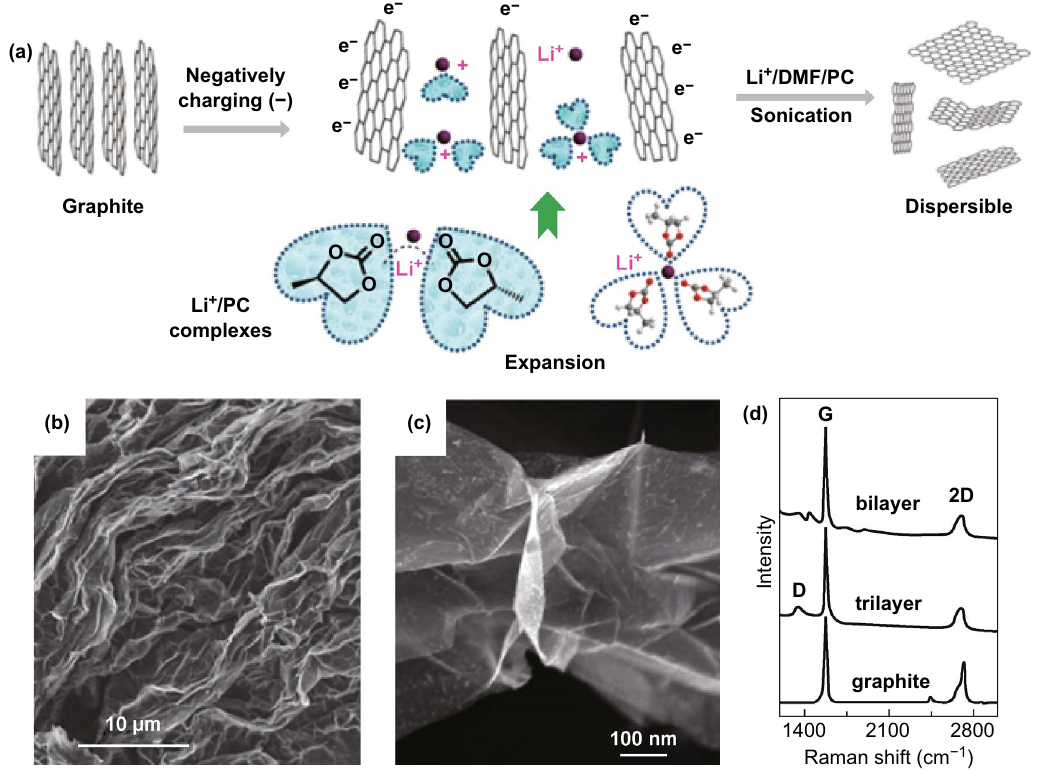
Fig. 8 a Schematic illustration of cathodic exfoliation of graphite by intercalation of Li + complexes. b , c SEM images of the cathodically exfo‑ liated graphene plates. d Raman spectra of the cathodically exfoliated graphene with bilayers and trilayers, in comparison with that of pristine graphite. Adapted from Ref. [21] with